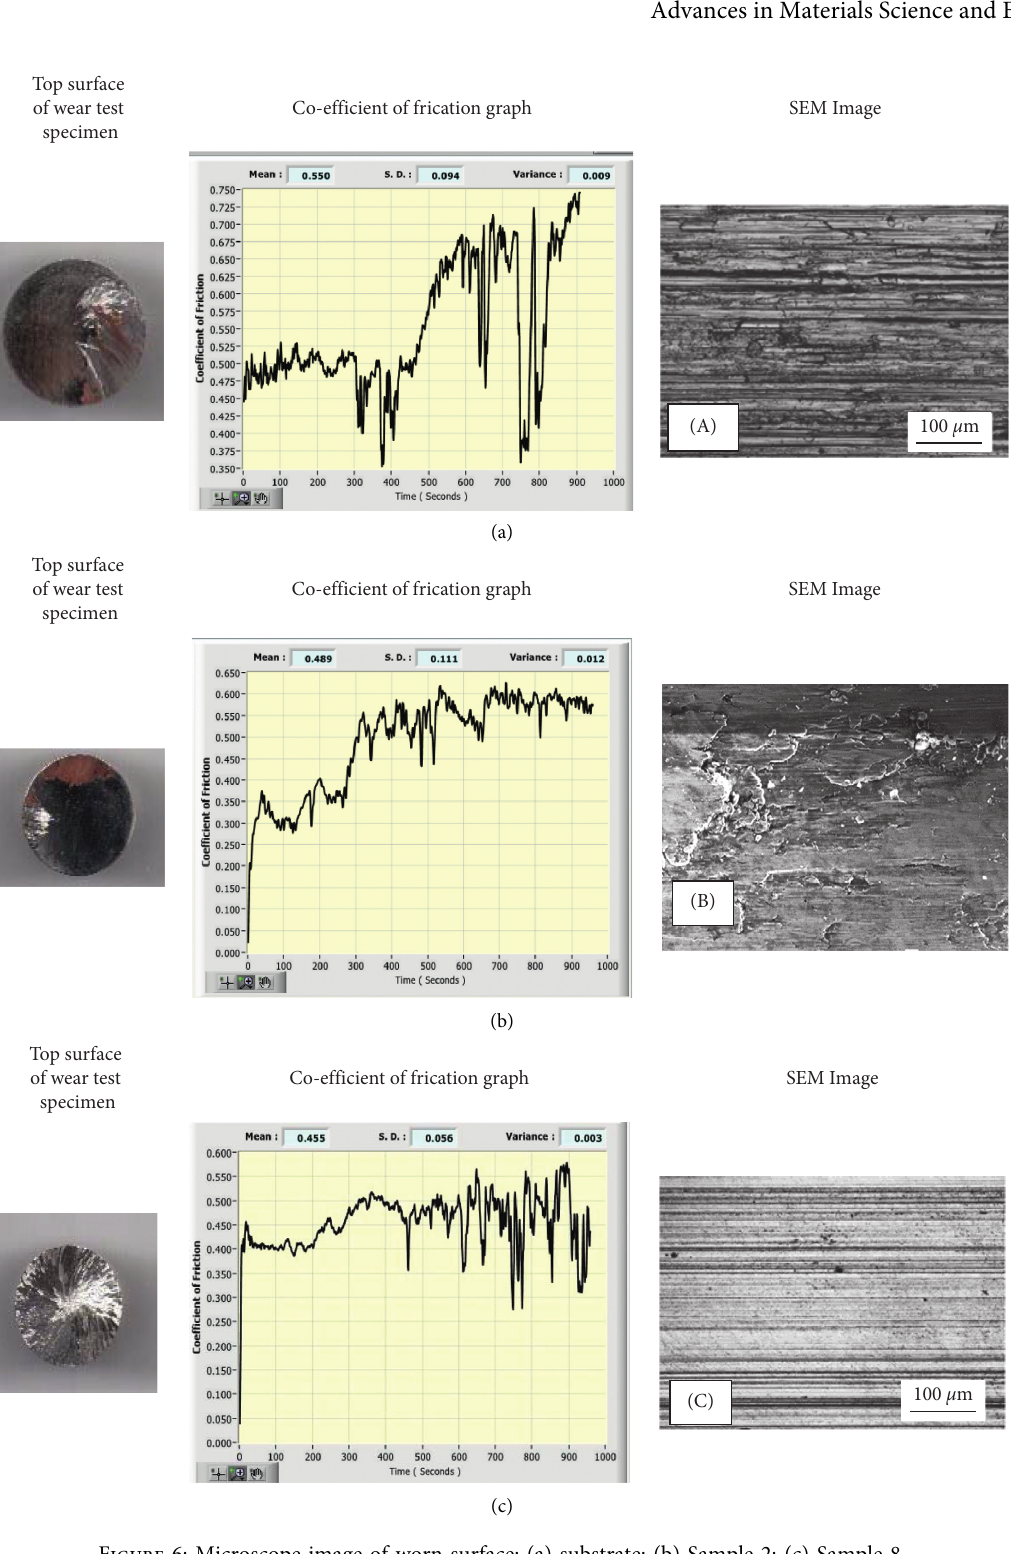
Figure 6: Microscope image of worn surface: (a) substrate; (b) Sample 2; (c) Sample